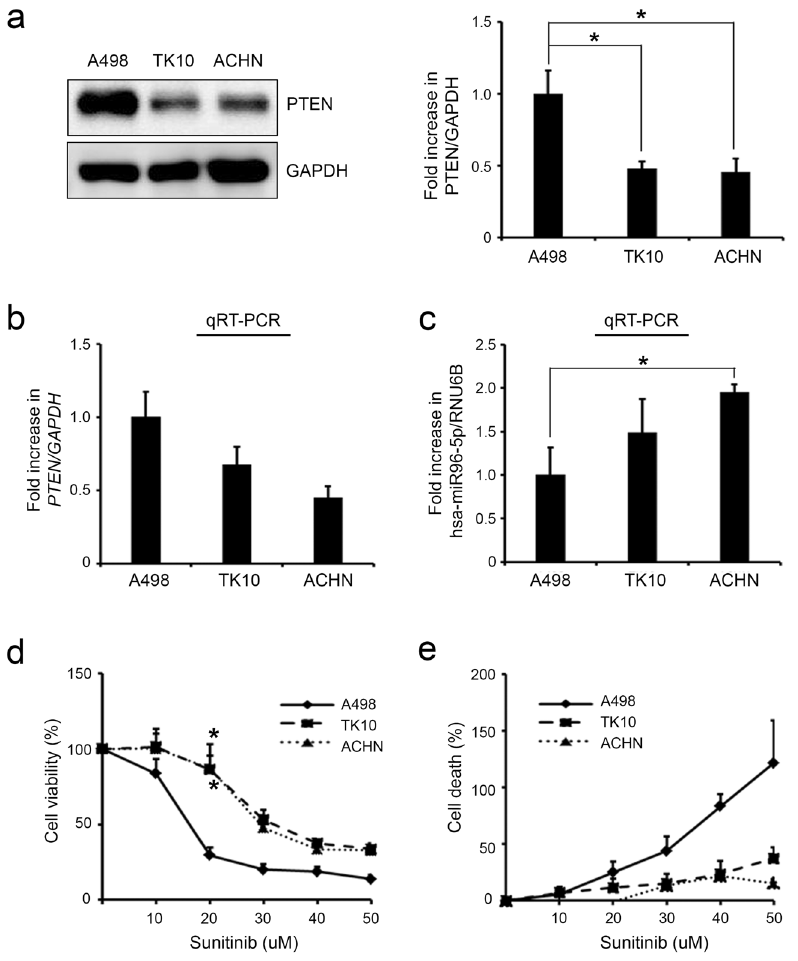
Figure 6. Downregulation of PTEN and upregulation of miR-96-5p are associated with sunitinib resistance in CCRCC cell lines. ( a ) Western blot (left) and quantification (right) of PTEN proteins in A498, TK10, and ACHN cells. GAPDH was used as a loading control. ( b , c ) The levels of PTEN mRNA ( b ) and miR-96-5p ( c ) were analyzed by qRT-PCR in A498, TK10, and ACHN cells. All data were normalized with GAPDH for mRNA or RNU6B for miRNA. ( d , e ) Dose-dependent effect of sunitinib on the viability ( d ) and death ( e ) of A498, TK10, and ACHN cells. Data are presented as mean ± s.e.m. (n = 3). Significant results are presented as * P <